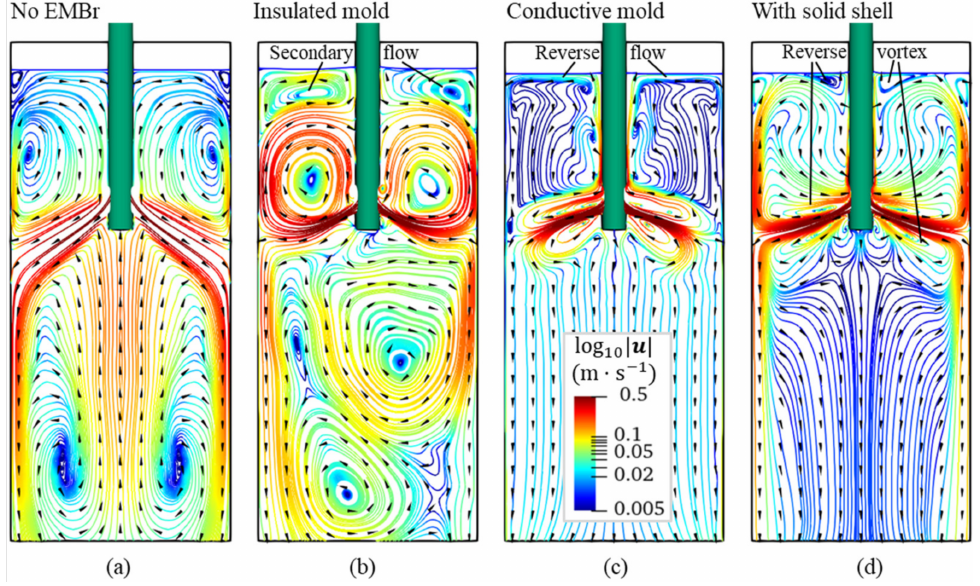
Figure 15. Time averaged velocity stream-lines (midplane), SEN immersion depth of 100 mm: ( a ) Case 0A; ( b ) Case 1A; ( c ) Case 2A; ( d ) Case